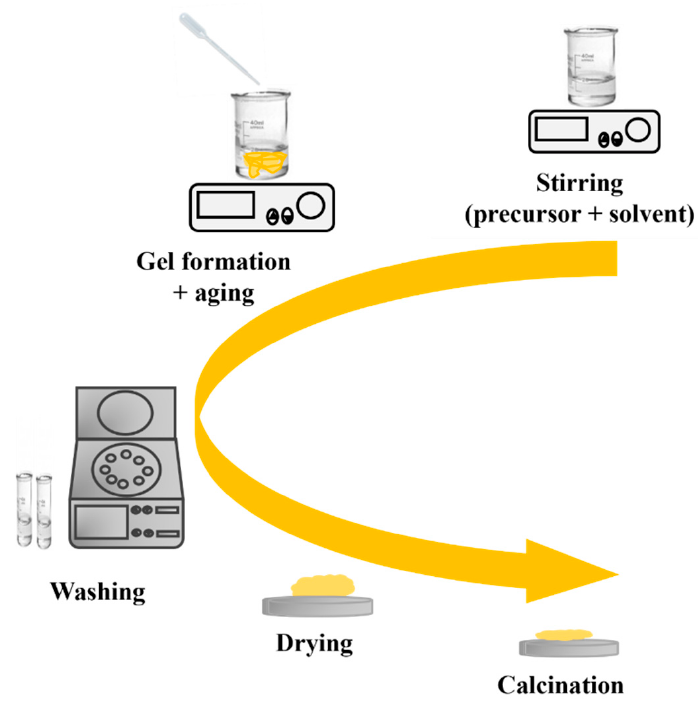
Figure 8. The key processing steps in the sol–gel method.